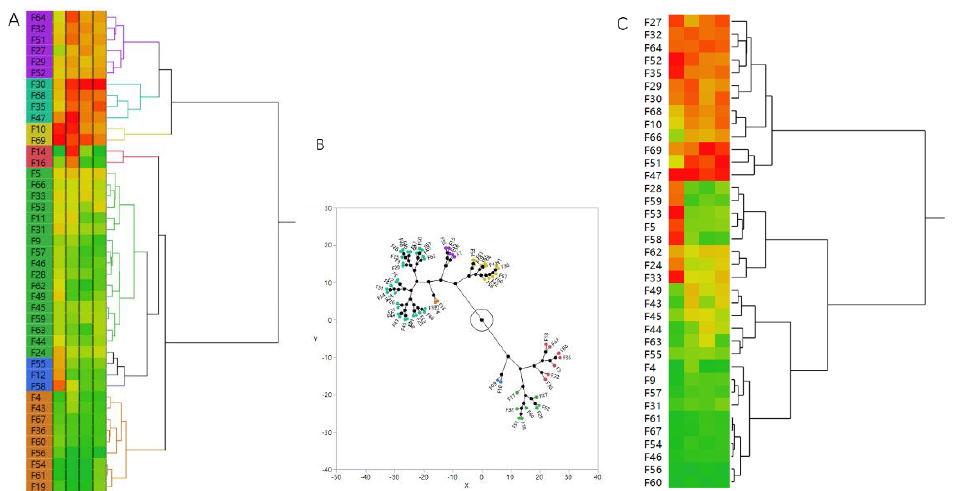
Figure 3. Cluster heat map analysis of fecal samples based on gas and ammonia production ( A ): the cluster ( A ) and constellation ( B ) diagram of gas production; the cluster diagram of ammonia production ( C ).